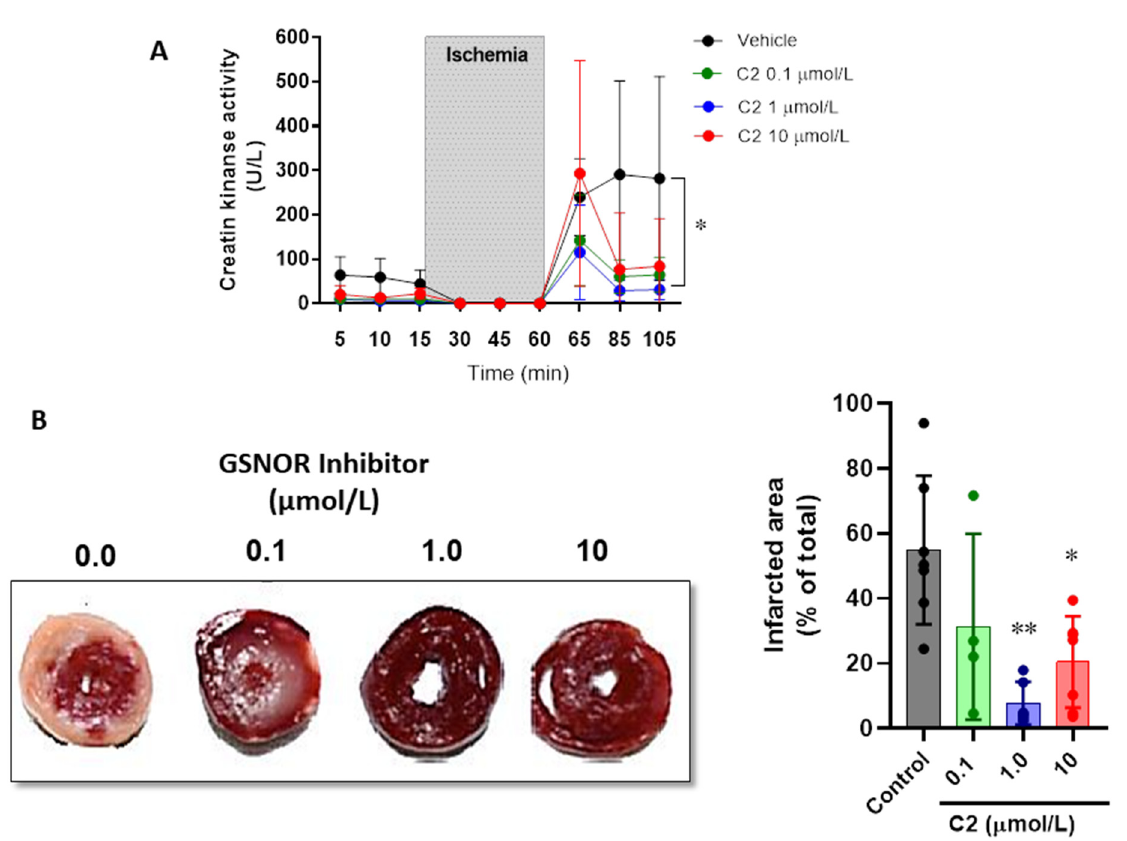
Figure 2. Impact of GSNOR inhibitor on cardiac damage in ischemia–reperfusion. ( A ), levels of creatine kinase release in the coronary effluent of Langendorff perfused hearts in the presence of increasing concentrations of the GSNOR inhibitor C2 and controls (vehicle). ( B ), representative images of hearts stained with TTC after being submitted to a protocol of ischemia–reperfusion, under control conditions or in the presence of the GSNOR inhibitor C2 at 0.1, 1 and 10 µmol/L. Right, graph depicting the analysis of the infarcted area. Asterisk (*) indicates p < 0.05 and **, p < 0.005 compared to vehicle (control), by two-way ANOVA (creatine kinase) and one-way ANOVA with multiple comparisons for infarct size analysis. n = 5 in each group.